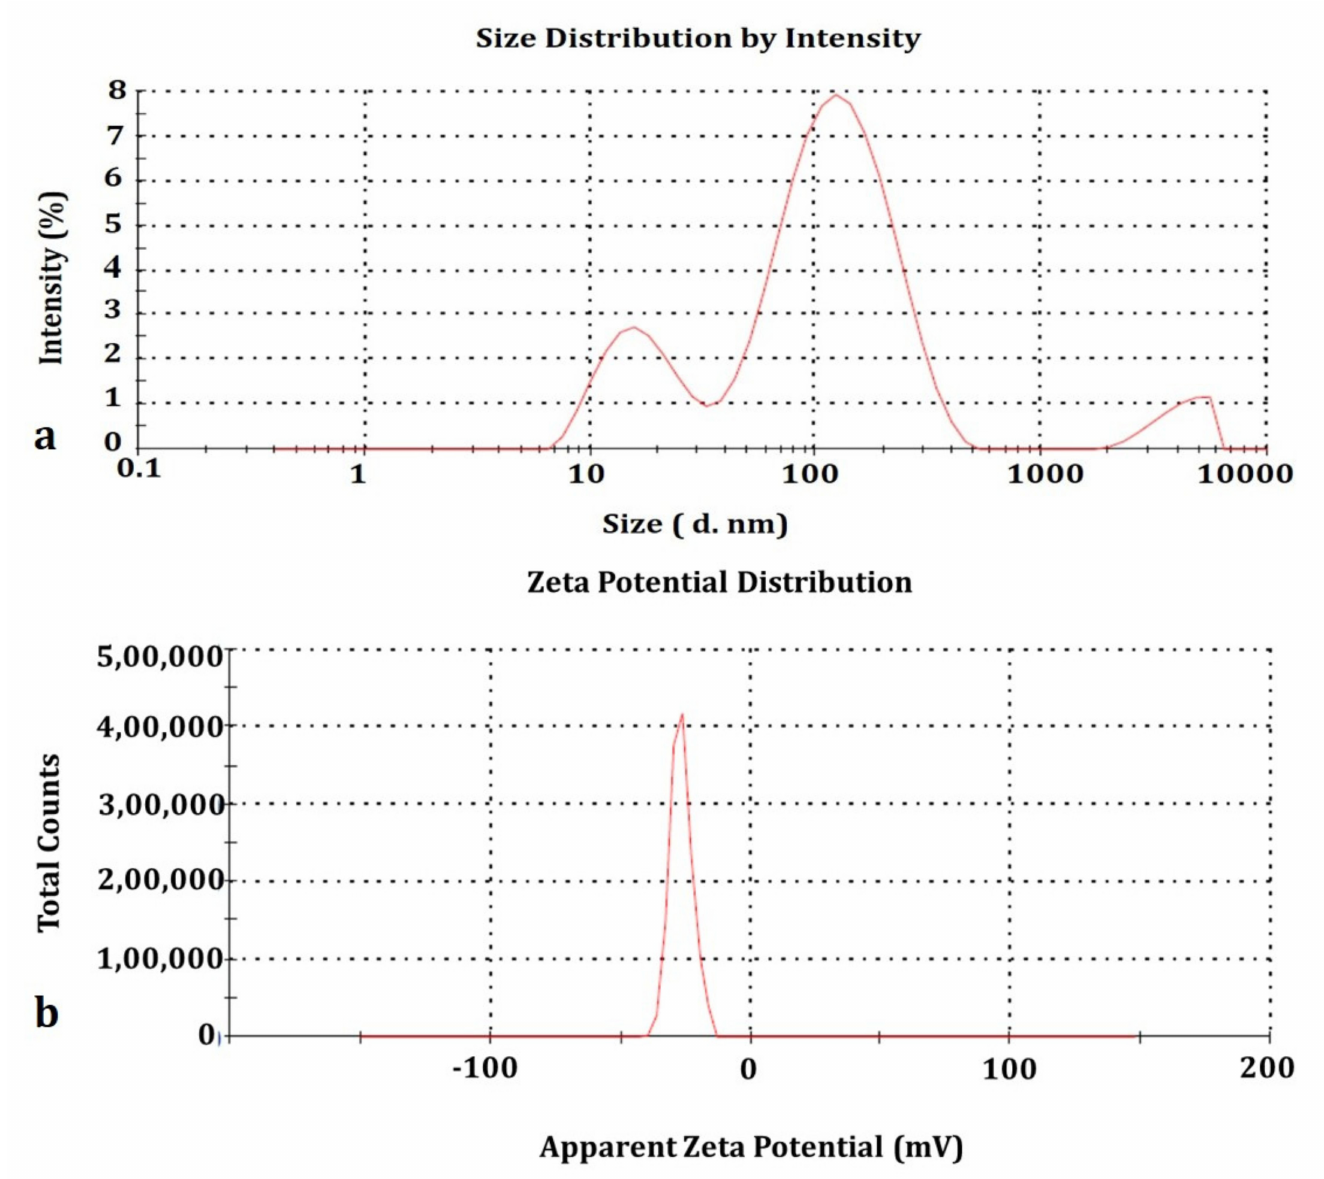
Figure 5. DLS analysis of C 60 -AgNPs nano-composites ( a ) Average Size distribution ( b ) Surface